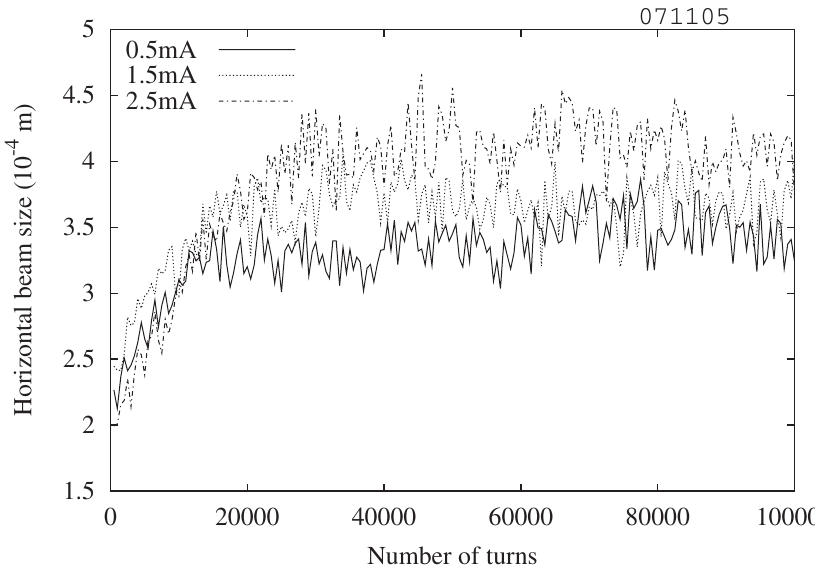
FIG. 2. Fitted horizontal size of the weak beam distribution at the interaction point vs number of turns for several bunch currents.